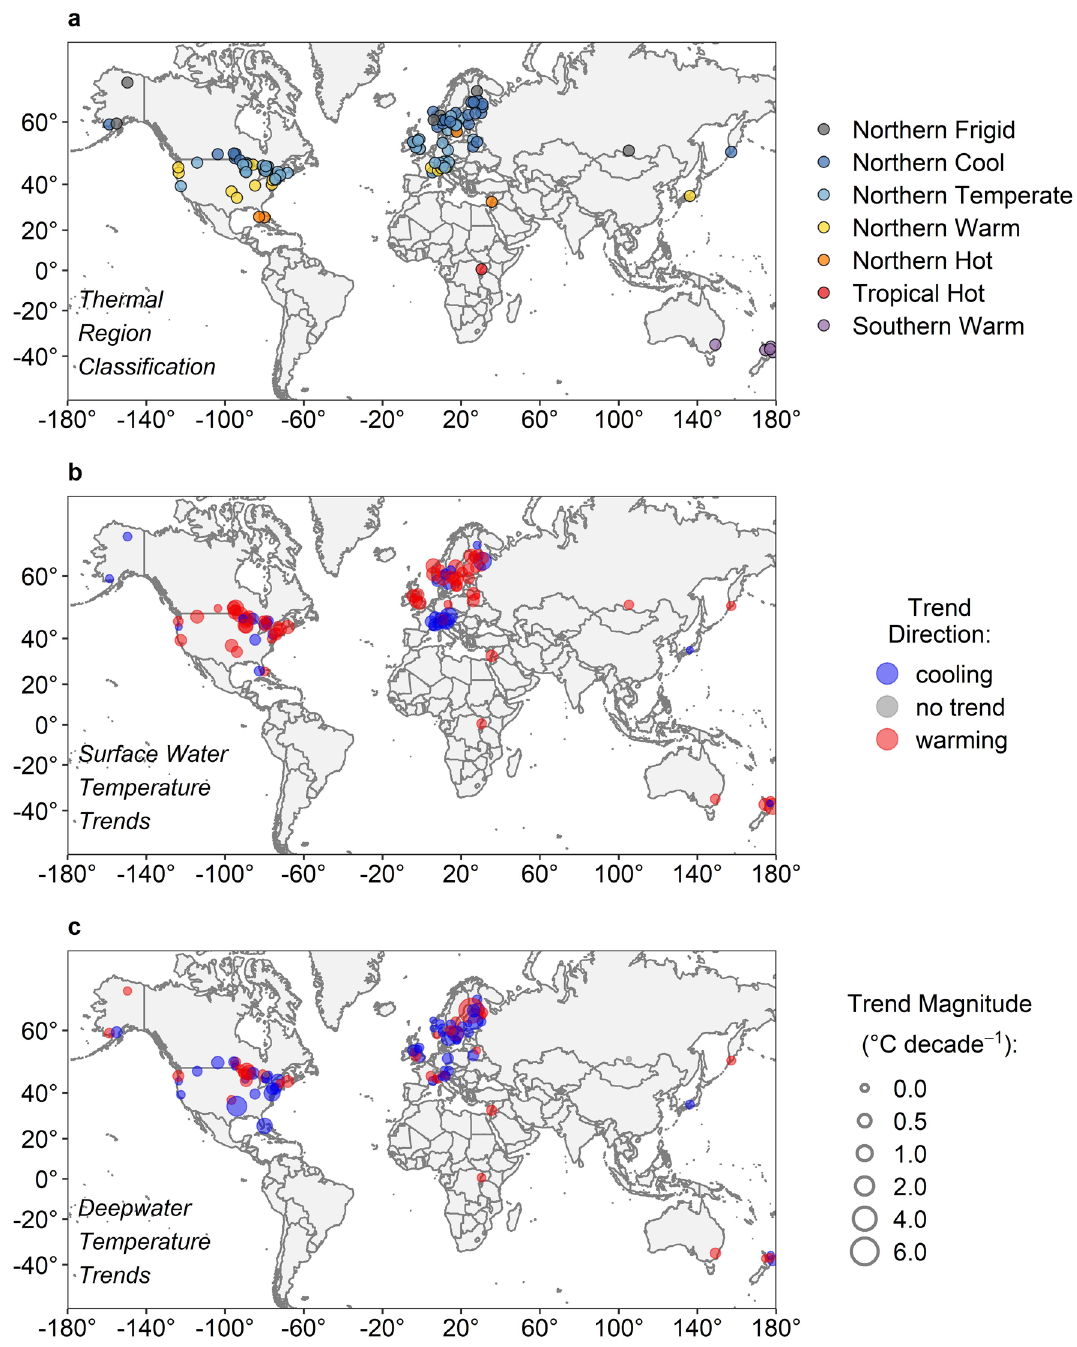
Figure 1. Map of the 102 lakes included in this analysis. Panels indicate ( a ) the thermal region classification for all lakes, and trends for ( b ) surface water temperature and ( c ) deepwater temperature. Panels ( b , c ) have a common legend, where point colour represents trend direction (red = warming, blue = cooling), and point size represents trend magnitude. Regions with high densities of lakes have had their exact latitude and longitude slightly shifted for visual clarity. Maps were generated in R version 3.5.0 88 , and with world map data from the “ggplot2” R package 89